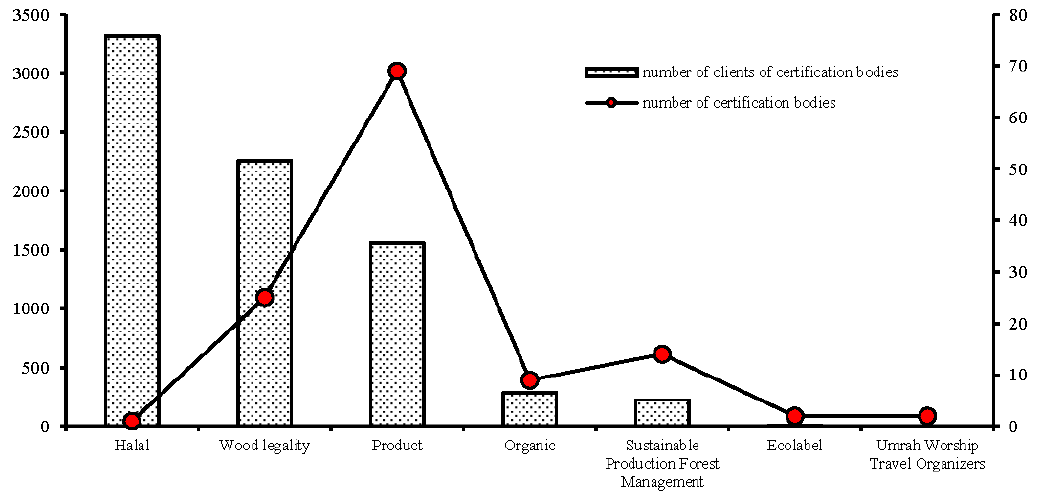
Figure 7: Profile of product certification bodies in